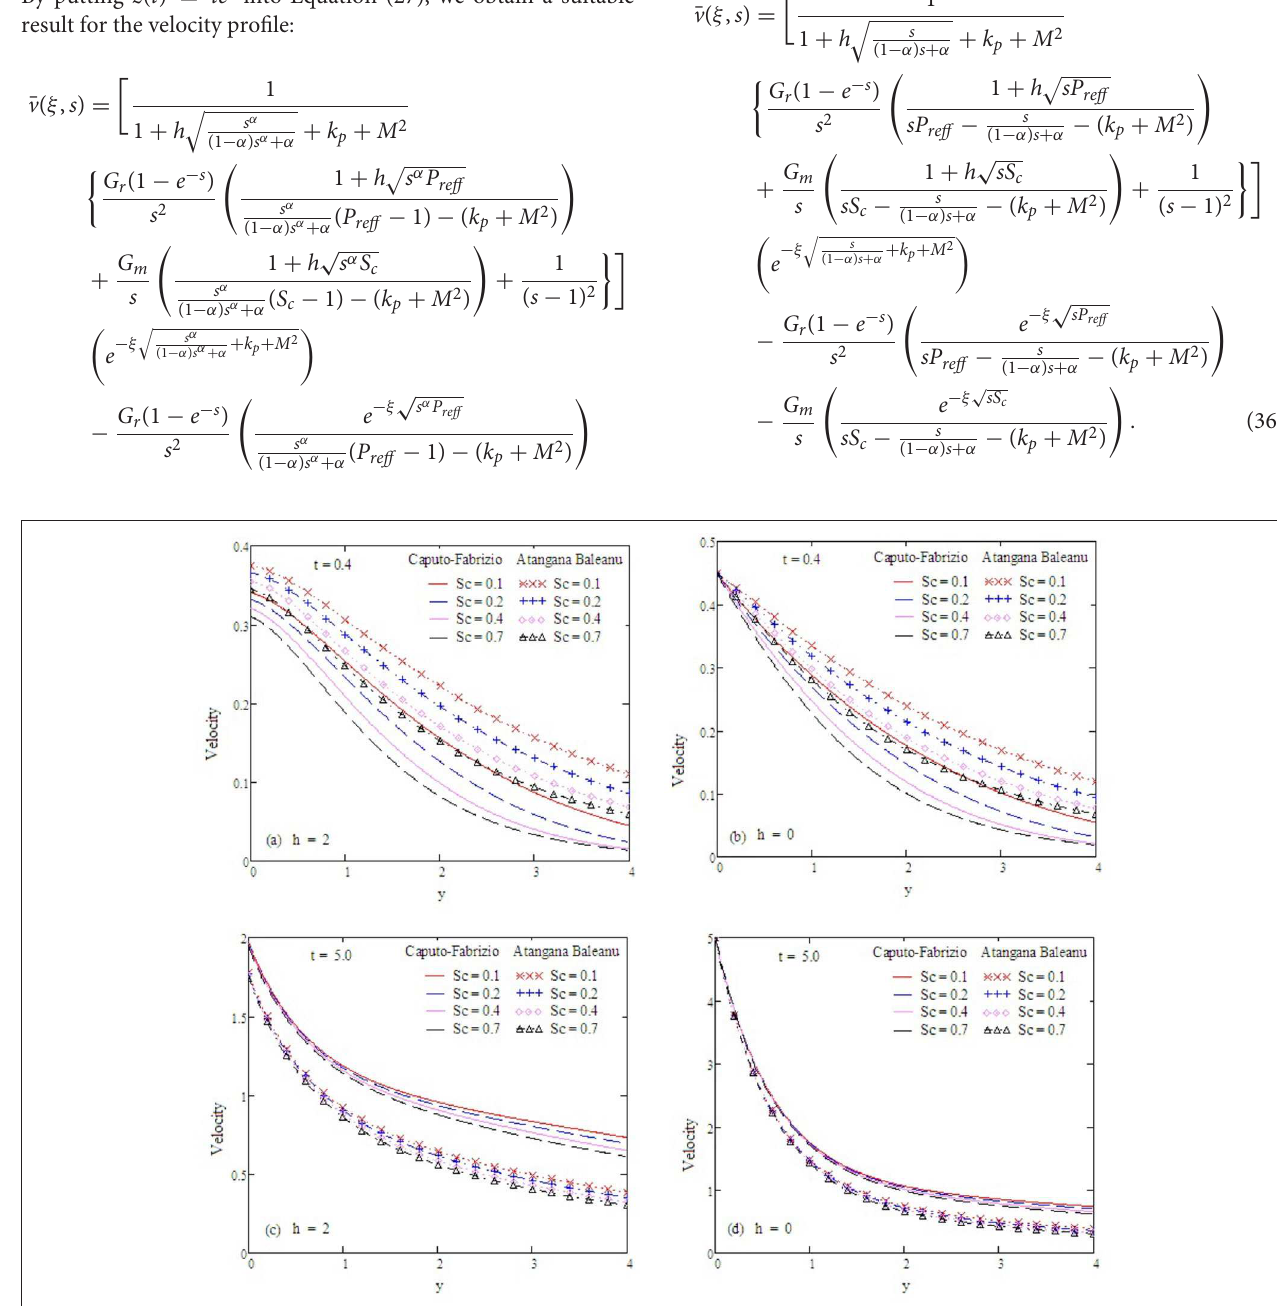
FIGURE 9 | Velocity profiles with altered values of S c and other parameters are α